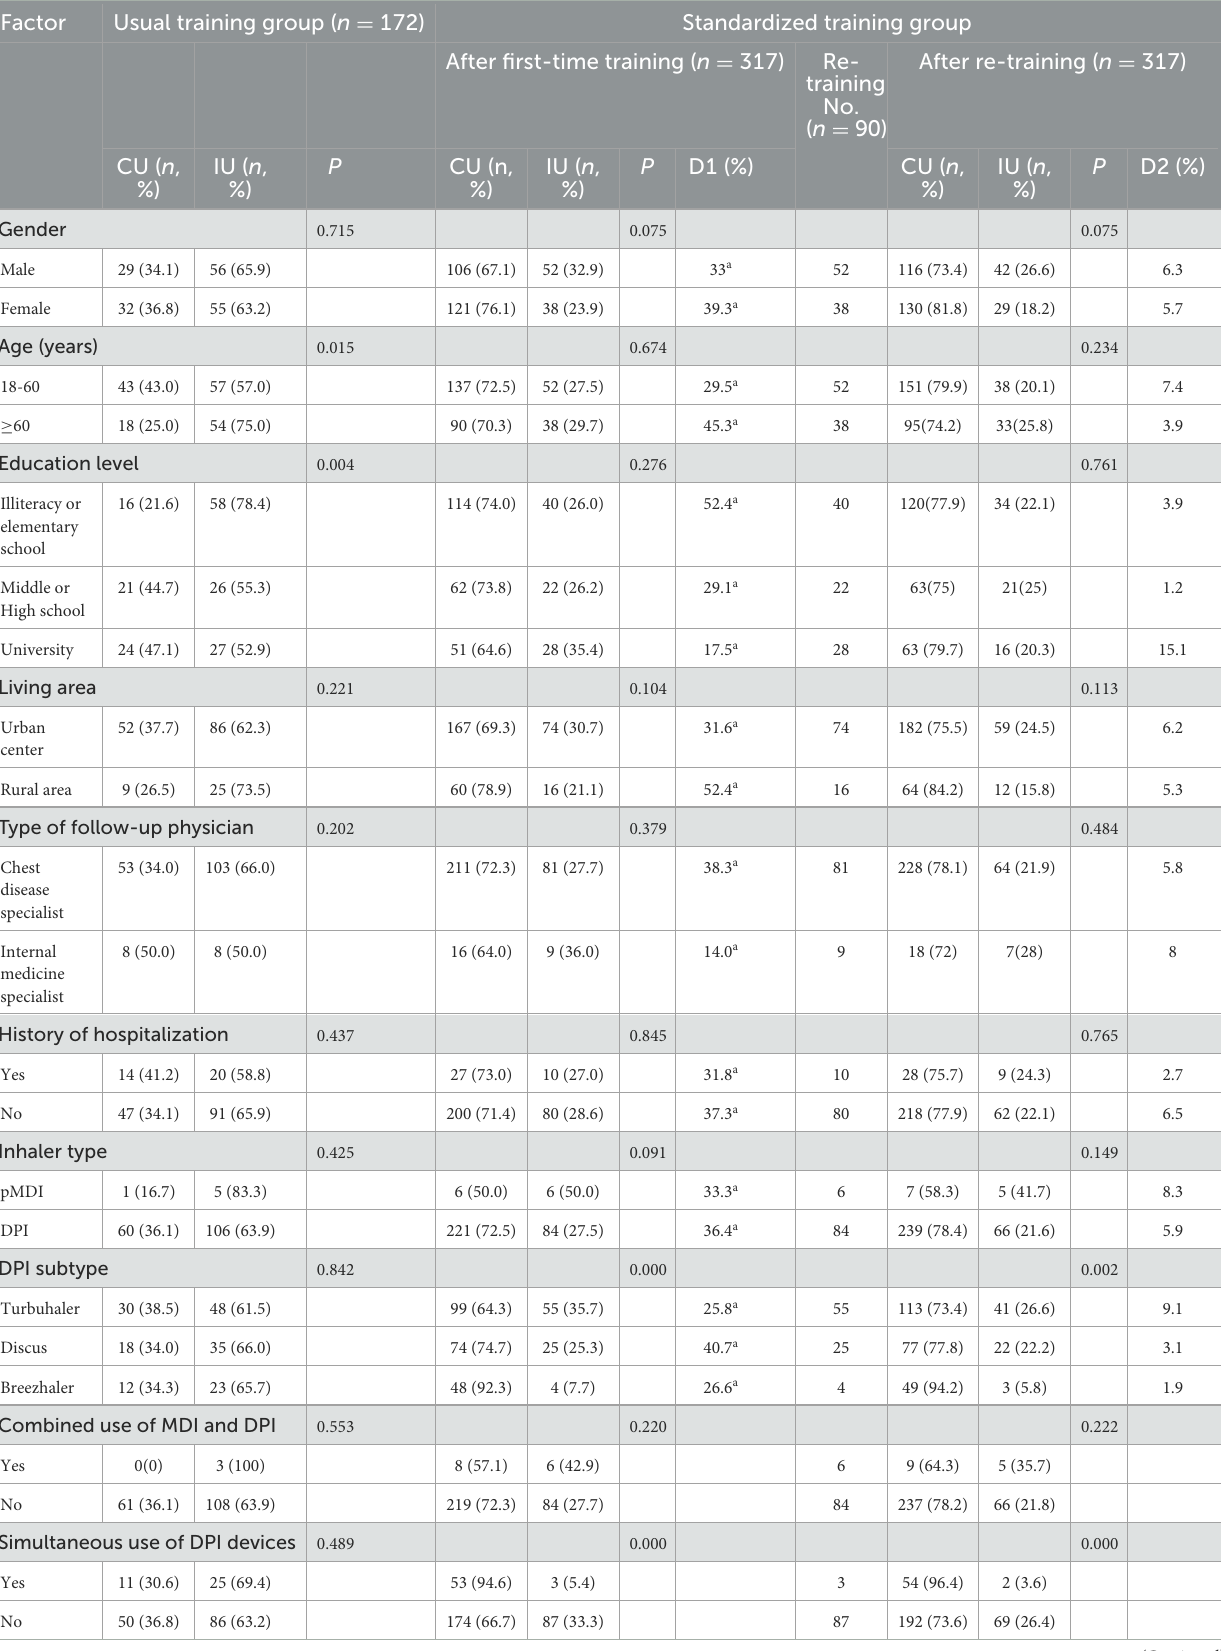
TABLE 4 Quantitative differences in inhaler use ability between the two models using a stratified analysis. Factor Usual training group ( n = 172) Standardized training group After first-time training ( n = 317) Re-